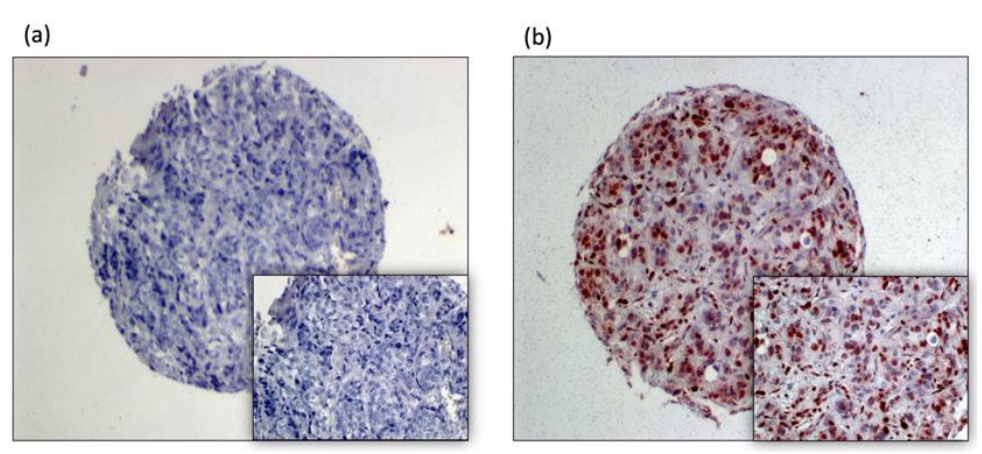
Figure 1. pSTAT3 expression, breast cancer tissue microarray sports as follows: ( a ) pSTAT3 negative, ( b ) pSTAT3 strongly positive.